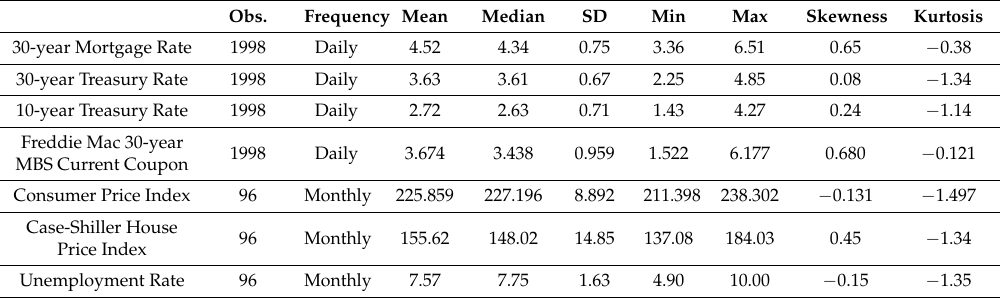
Table A1. Summary of data. This table reports the descriptive statistics of the variables used in this paper. All the rates are in percentage and the indices are in level. The sample period spans from 1/1/2008 to 12/31/2015. Obs.